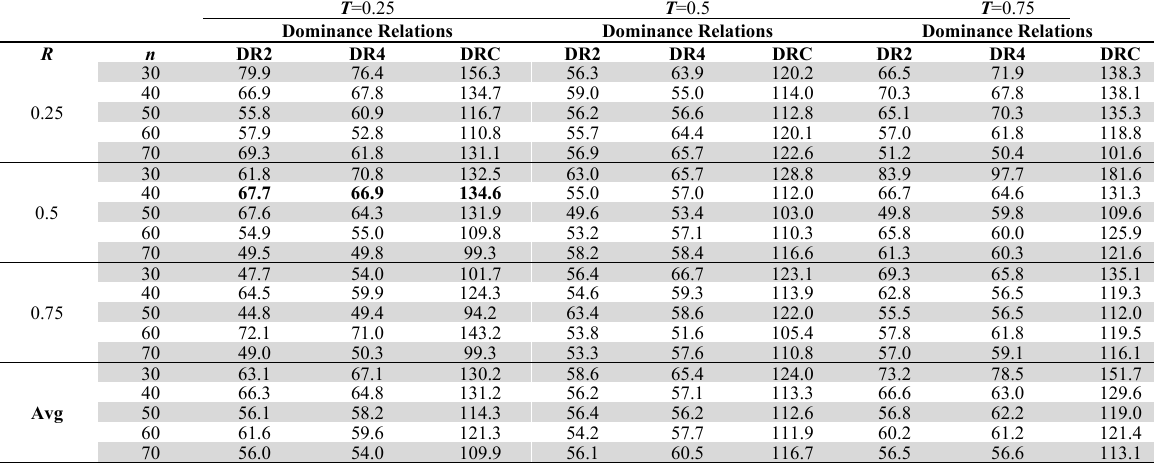
56.5 56.6 113.1